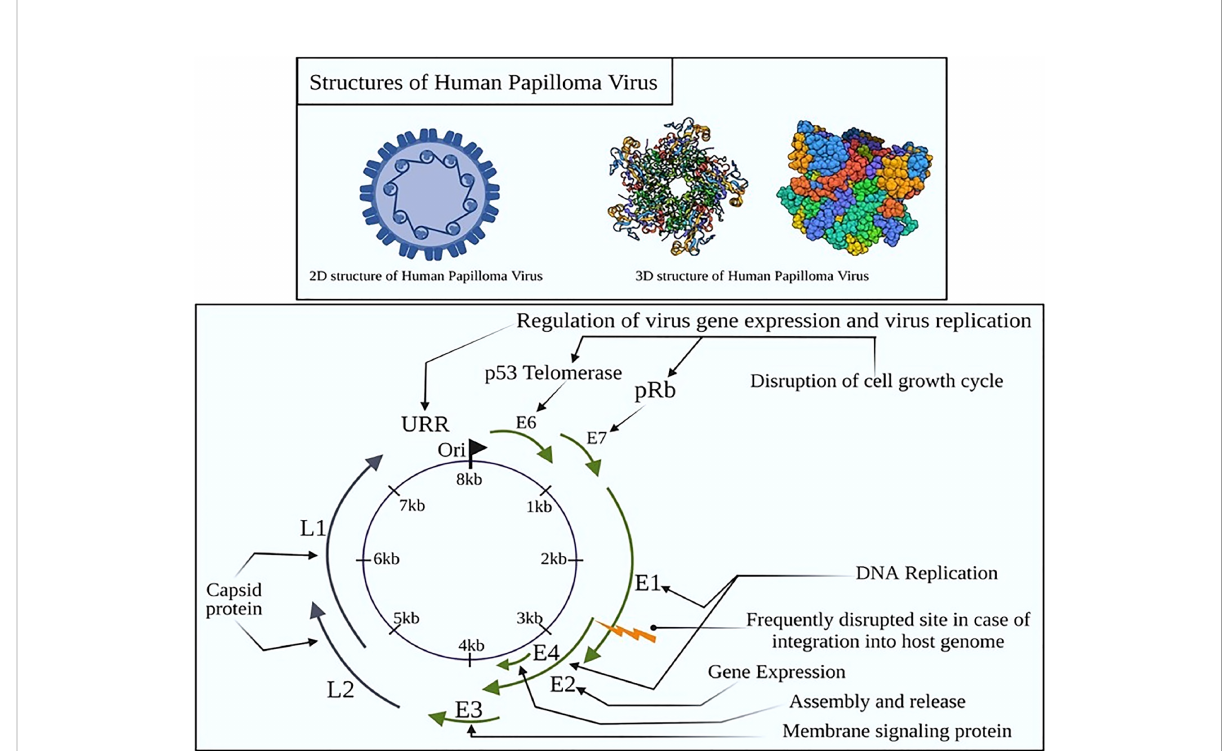
FIGURE 1 Structural organization of HPV with early and late proteins. E proteins are non-structural and have a role in viral genome duplication and expression although the L proteins form the capsid of the intact virion. In cervical cancer, these proteins activate the oncogenes to